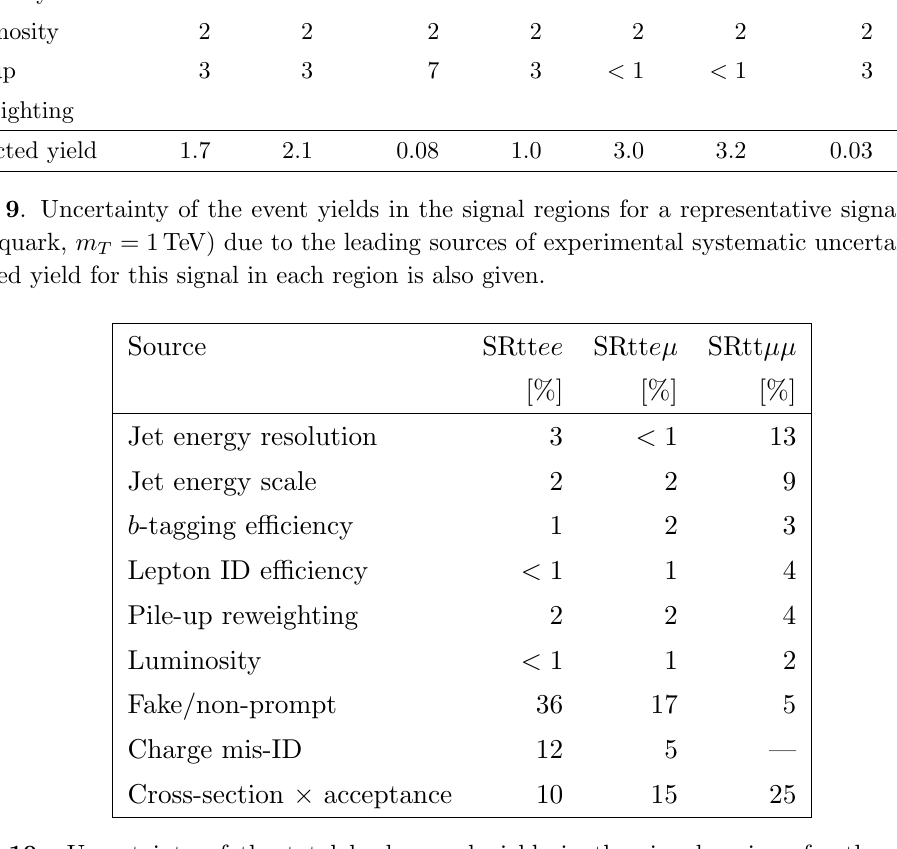
Table 10 . Uncertainty of the total background yields in the signal regions for the same-sign top-quark pair production search due to the leading sources of systematic